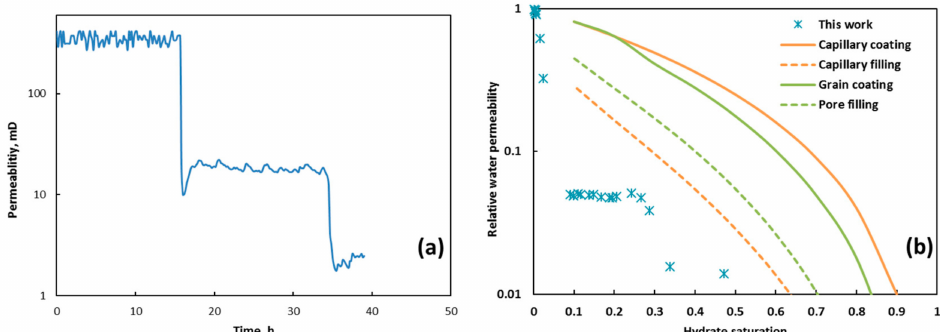
Figure 9. Permeability and relative water permeability of hydrate-bearing sediments: ( a ) Variation of permeability during hydrate formation in the sediments. ( b ) Comparison of relative water permeability under di ff erent hydrate saturations between experiment and predicted